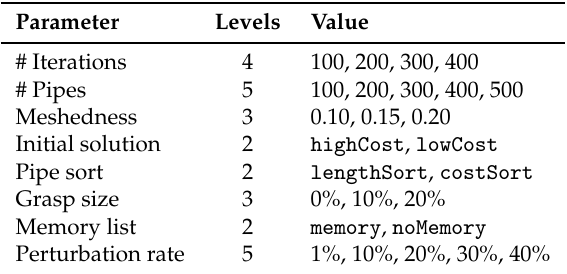
Table 2. Parameters and their tested